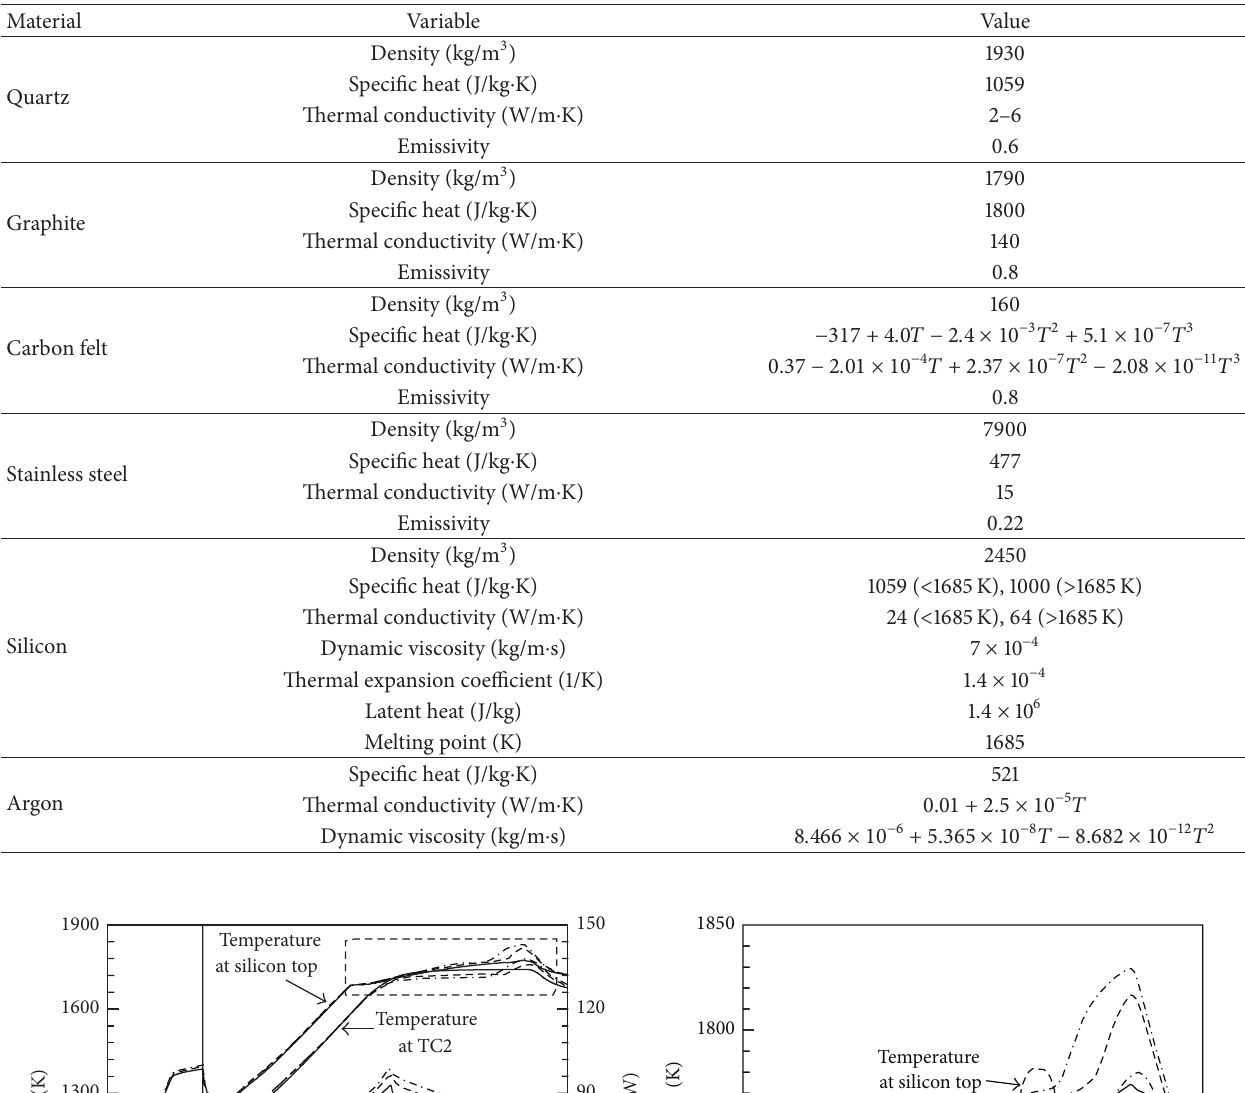
Table 1: Thermophysical properties of materials.